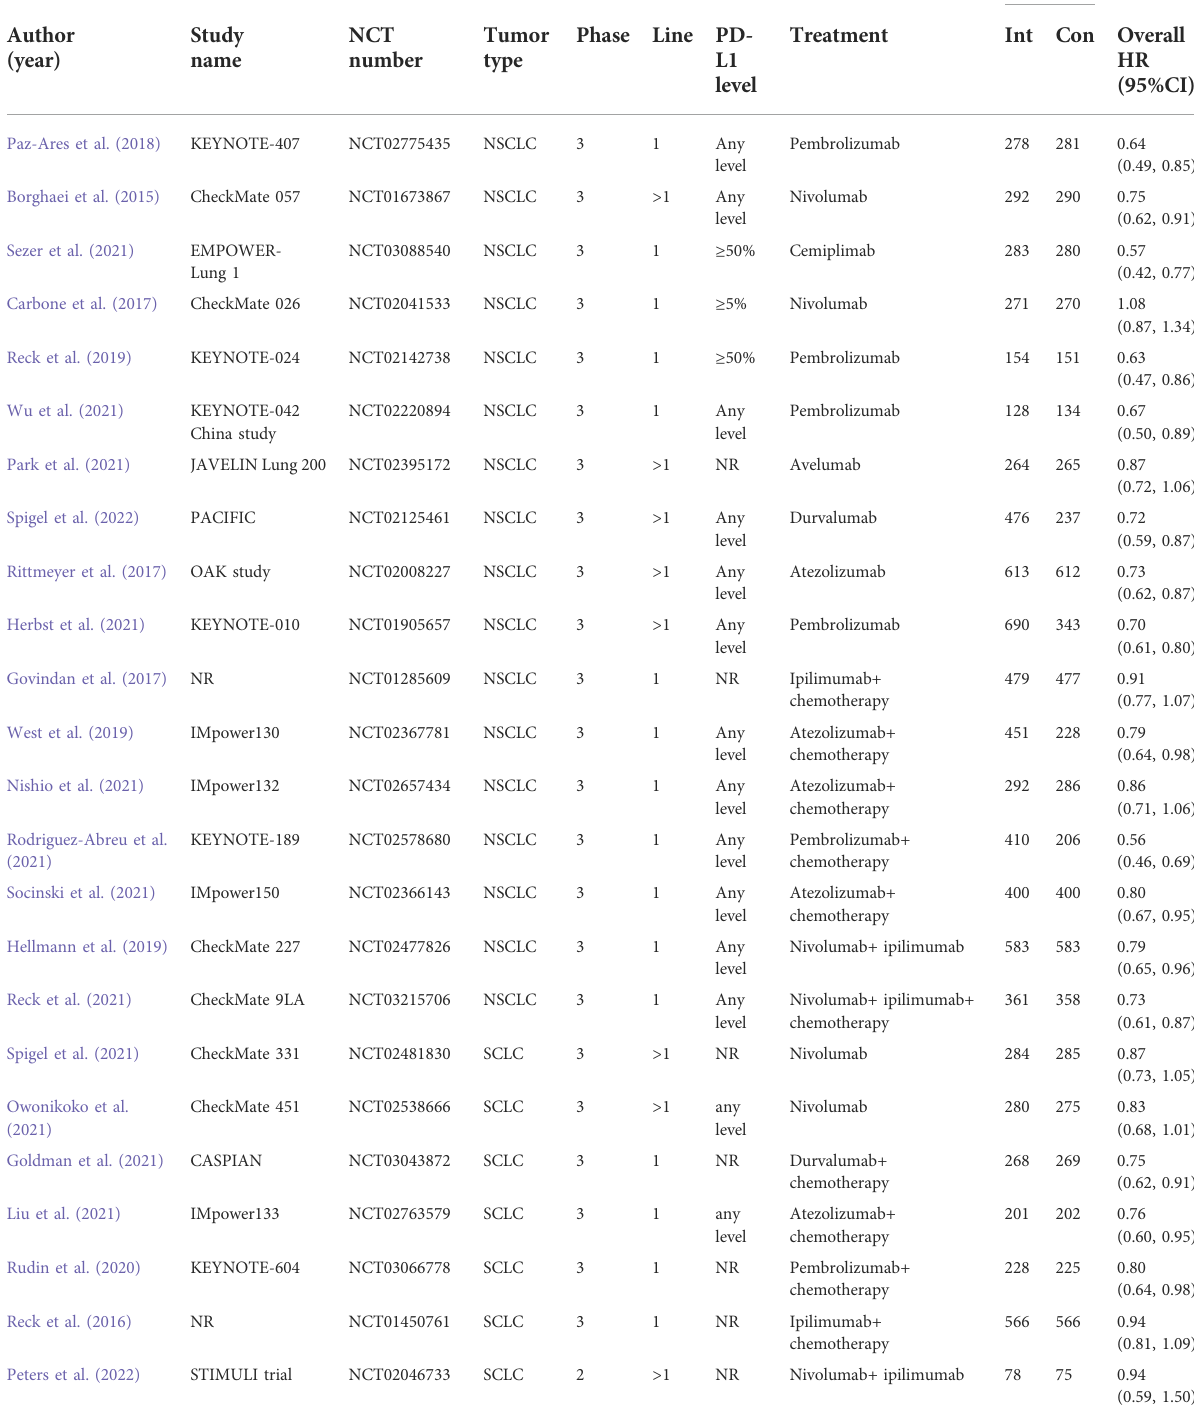
TABLE 1 Characteristics of included